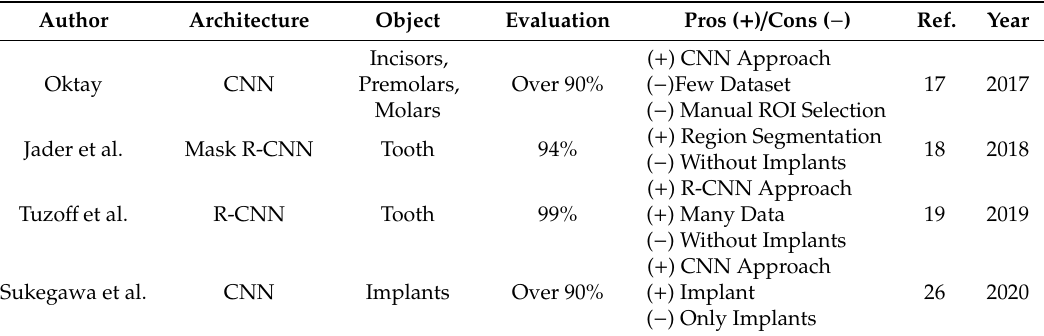
Table 1. Comparative overview table for machine learning article in the field of tooth